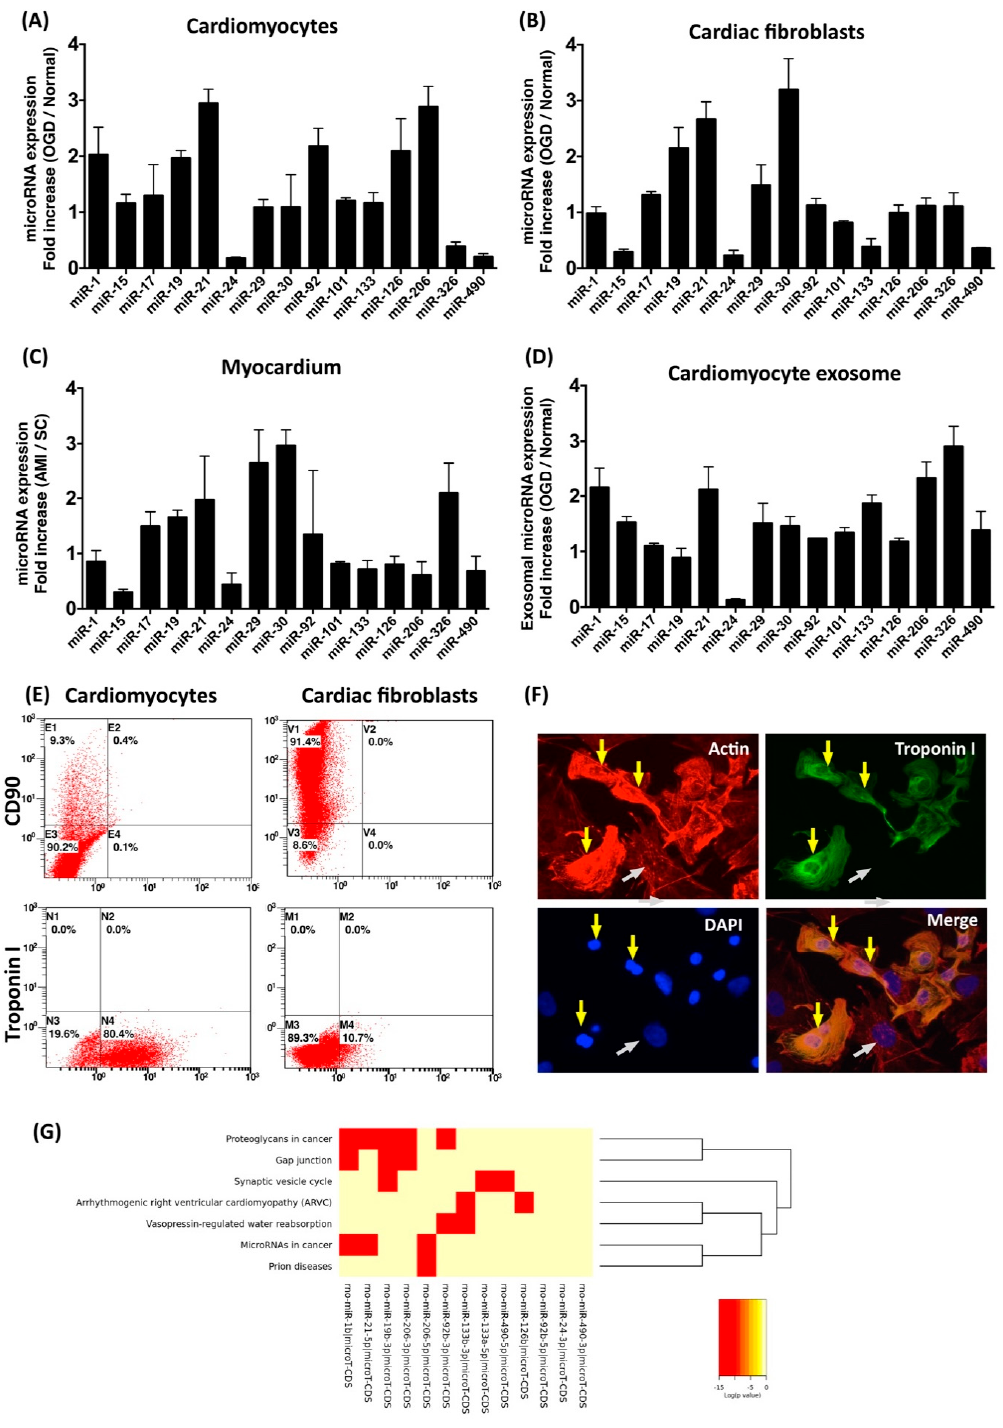
Figure 1. Expression profile of myocardial-disease-associated microRNA in myocardium, cardiac fibroblasts, cardiomyocytes, and cardiomyocyte-derived conditioned medium. ( A ) Relative expression level of miRNAs in cardiomyocytes incubated under oxygen–glucose deprivation (OGD) and normal (normoxia with serum and glucose supply) conditions for 6